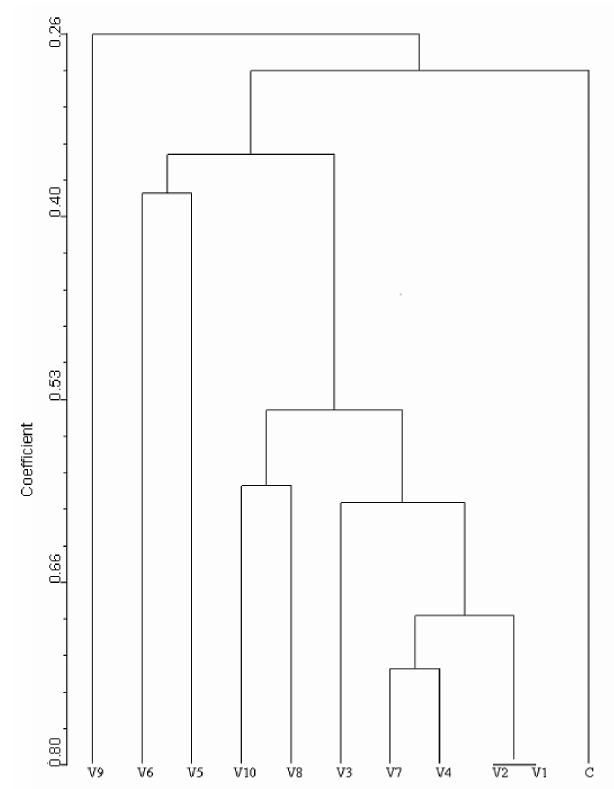
Fig. 3 - Dendrogram of control and mutants of chrysanthemum cv. Snow